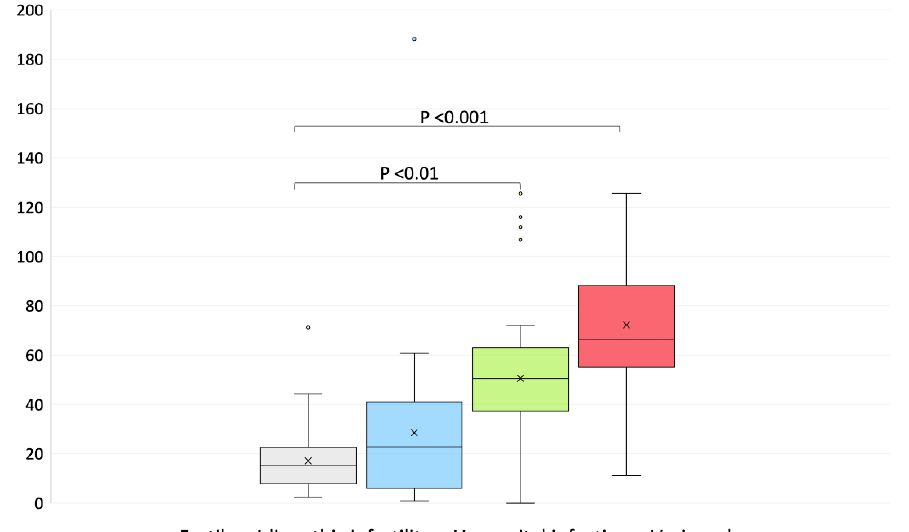
Figure 1. Box plot of the distribution of F 2 -IsoP concentrations (ng/mL) in fertile men and patients affected by idiopathic infertility, urogenital infections and varicocele.